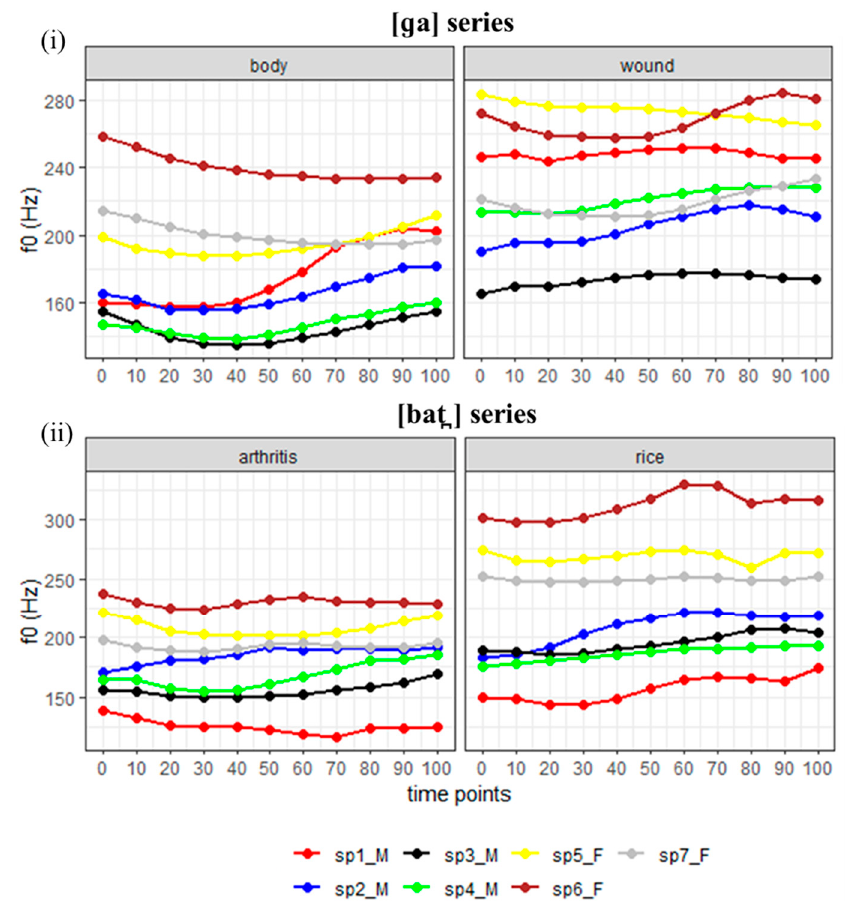
Figure 1. The loss of aspiration in [ ɡ a ] ‘wound’ [ ɡʰ > ɡ ] ( i ) and [ ba t ̪ ] ‘rice’ [b ʰ > b] ( ii ) led to a high tone in Sylheti. (n = 8) per subject for each word that has been shown in each panel (4 repetitions × 2 words).